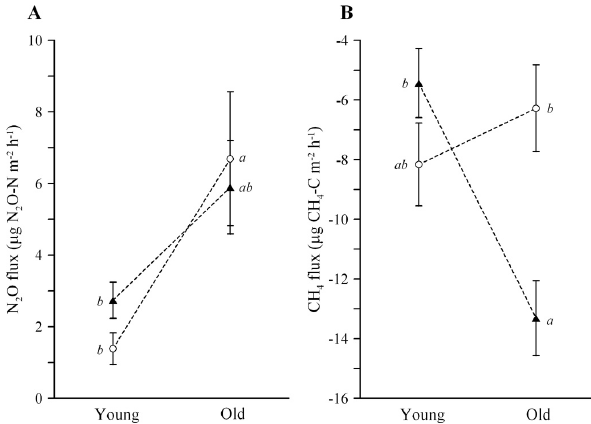
Fig. 2. Stand comparison of (A) soil water content (vol%), (B) soil temperature ( ◦ C) and (C) soil bulk density (gcm − 3 ) in 0–5cm. Er- ror bars ( ± std. error of the mean) represent the temporal variation. Different letters indicate significant difference ( p < 0 . 05). Oak ( N ) and Norway spruce ( ◦ ). Dashed lines are included for clarification and do not represent regression